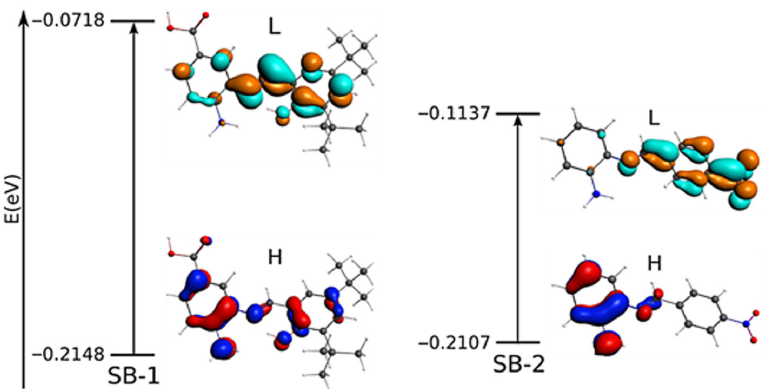
Figure 3. Qualitative molecular orbital diagram for SB-1 and SB-2 with the most important electronic transitions. Occupied orbitals: red and blue; unoccupied orbitals: orange and cyan. L: LUMO; H: HOMO.